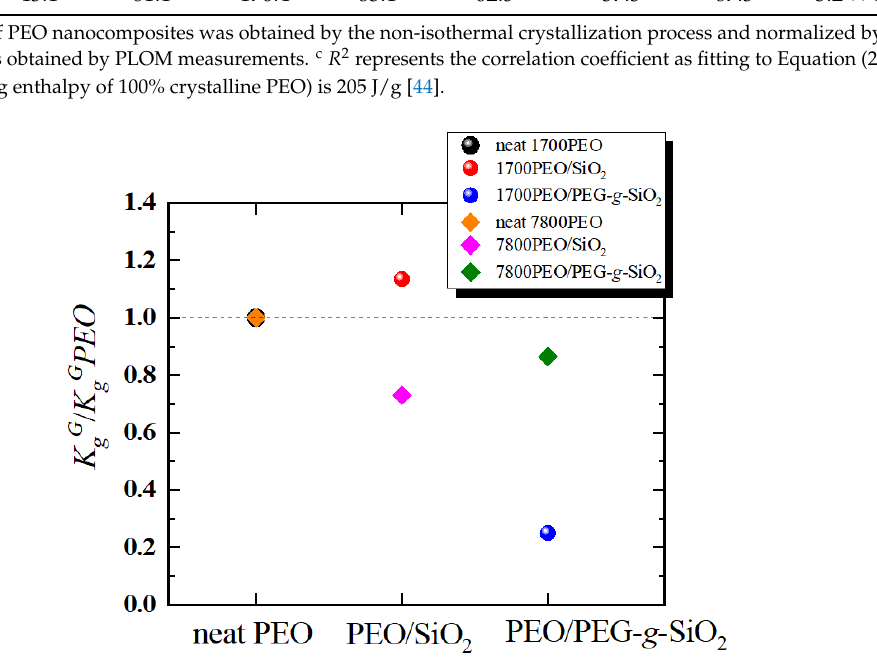
Figure 4. Changing tendency of each PEO nanocomposite in secondary nucleation energy barrier K G g vs. K G g PEO . Table 2. Secondary nucleation energy barrier K G g studied in different